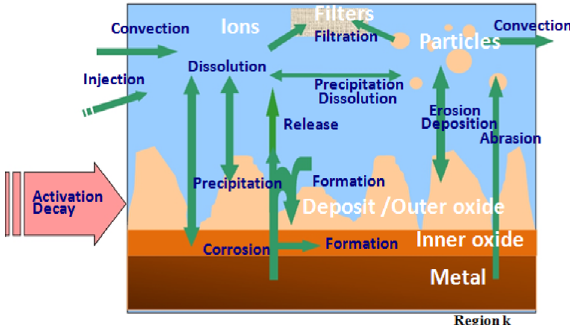
Fig. 1. Mass fl ux between the different media in an